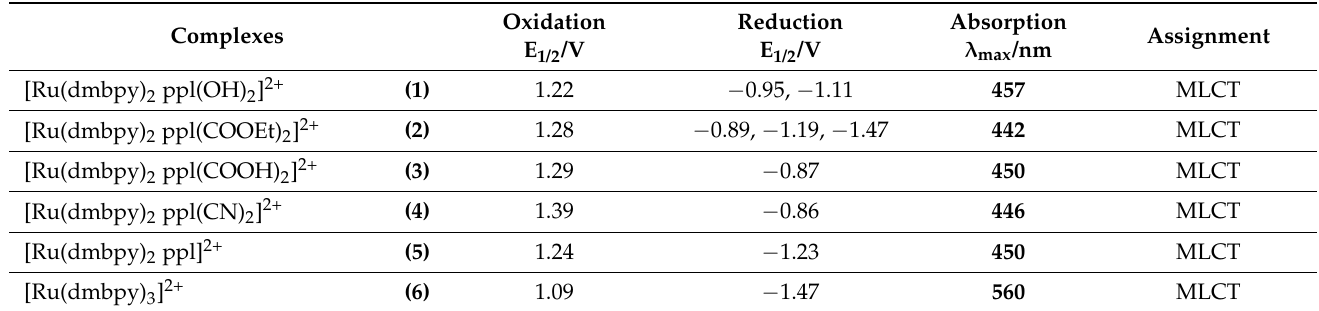
Table 3. Electrochemical and UV–Vis absorption properties of [Ru(dmbpy) 2 R 2 ppl] complexes in